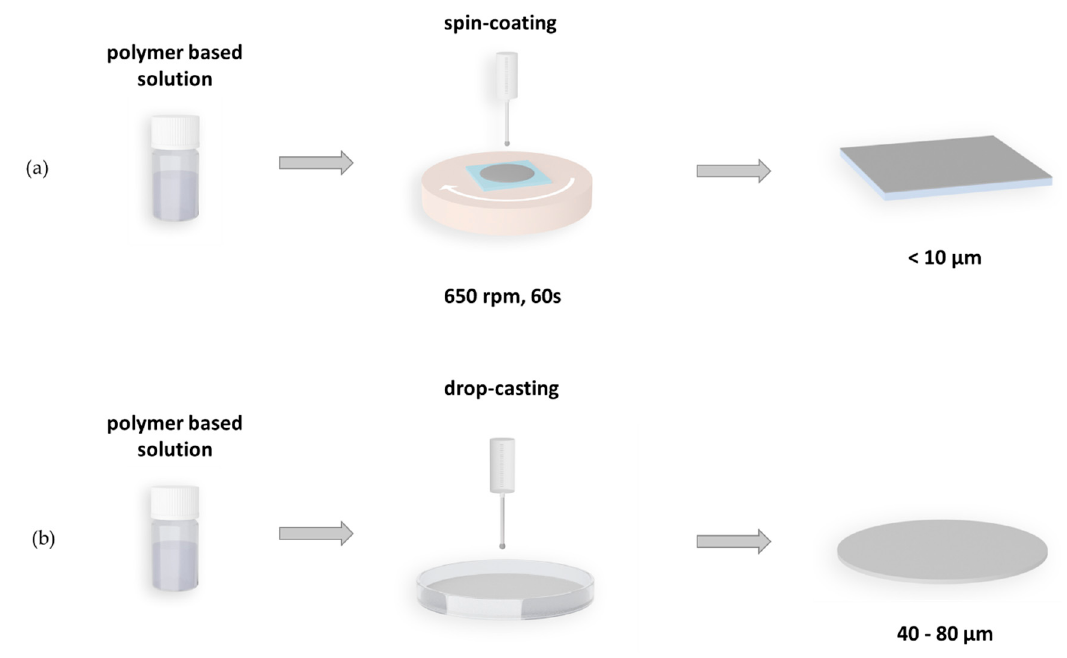
Scheme 3. Scheme of layer preparation using the spin coating ( a ) and drop casting ( b )